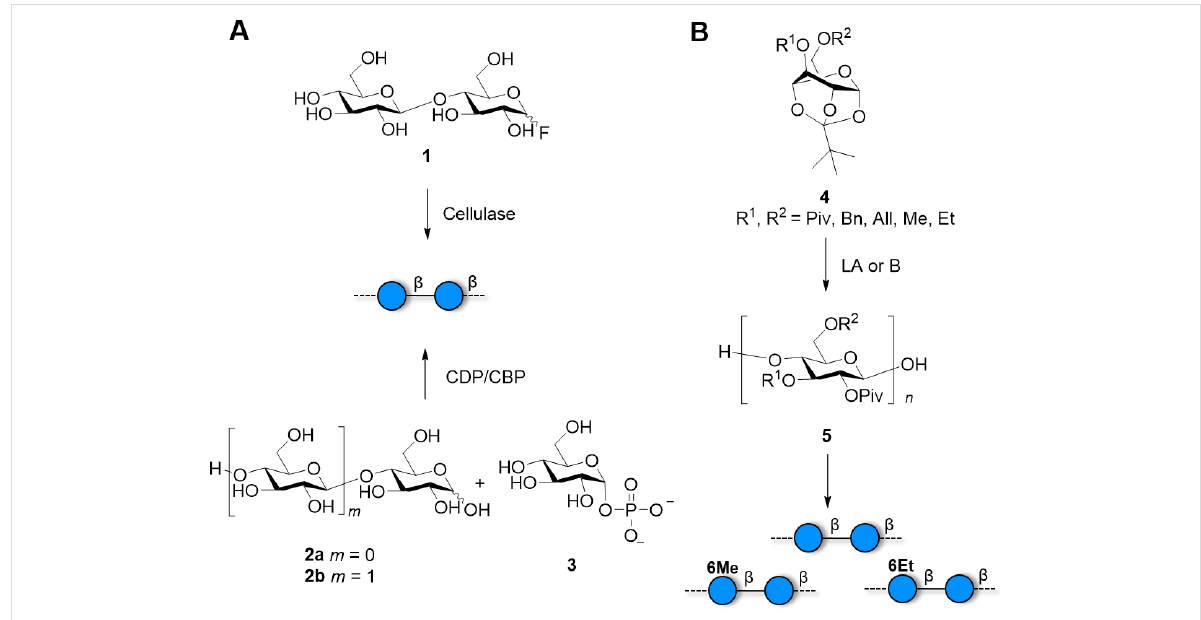
Scheme 1: Enzymatic and chemical polymerization approaches provide cellulose oligomers with a non-uniform distribution of MW. A) Cellulose oligomers can be synthesized using cellobiose fluoride 1 and cellulase. Other enzymes like cellodextrin phosphorylase (CDP) or cellobiose phospho- rylase (CBP) use glucose ( 2a ) or cellobiose ( 2b ) primer respectively and glucose phosphate 3 . B) Synthesis of cellulose by ROP from protected orthoester 4 promoted by Lewis acid (LA) or base